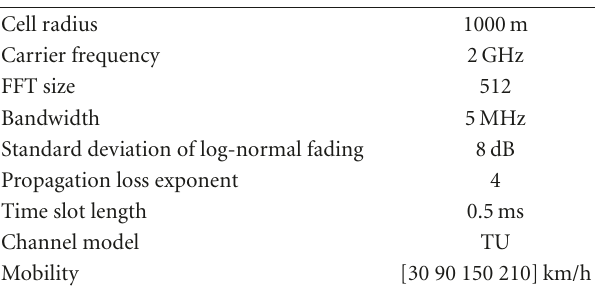
Table 1: Simulation parameters. Table 2: Number of dropped packets versus mobility for τ max =